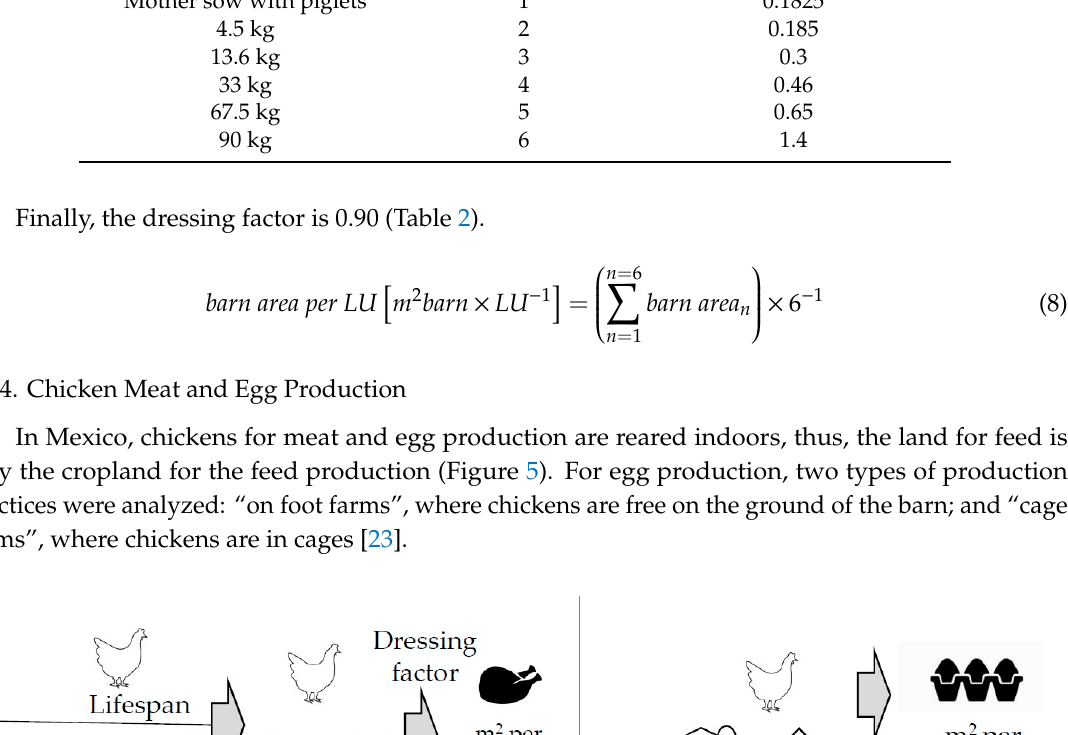
Table 3. Barn area required per pig based on live weight and age. Data source: [21].